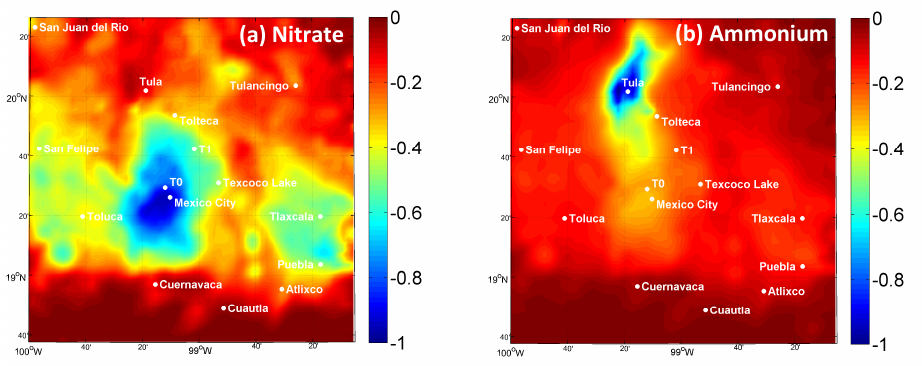
Figure 12: Predicted change (µg m -3 ) in ground-level concentrations of PM 1 (a) nitrate, and (b) ammonium after a 50% reduction of NH 3 emissions. A negative change corresponds to a decrease.